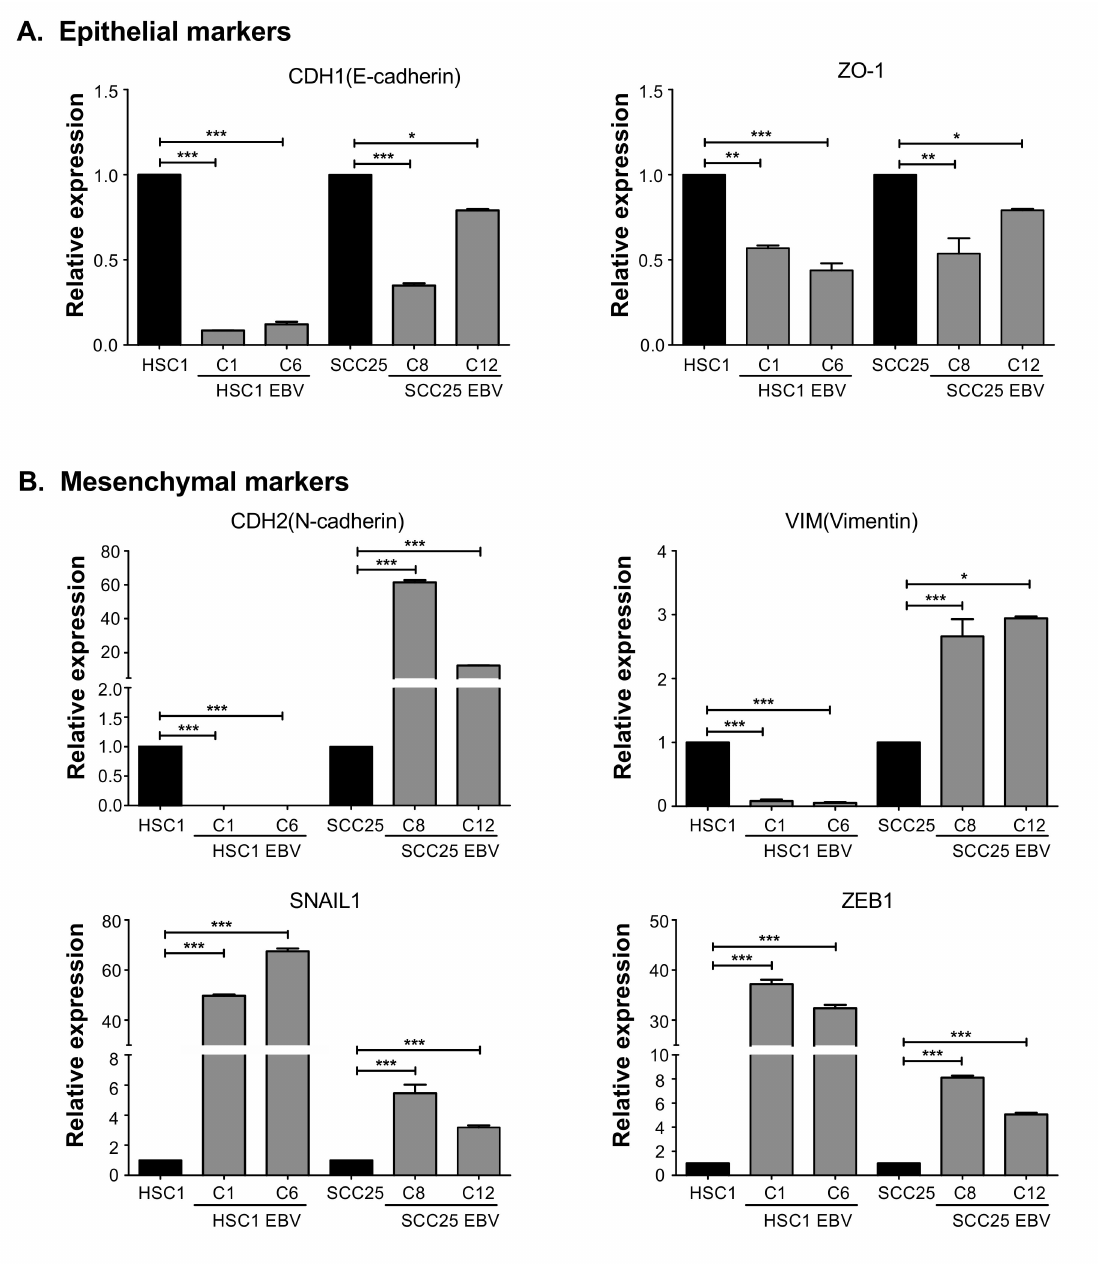
Figure 6. EBV infection induces mesenchymal properties in SCC cells. The expression of genes associated with EMT, including epithelial markers ( A ) CDH1, ZO-1, and mesenchymal markers ( B ) CDH2, VIM, ZEB1, and SNAIL1, was quantitated by qRT-PCR. *: p < 0.05; **: p < 0.01; ***: p < 0.001. 3.6. EBV Promotes Migration and Invasion in SCC Cells. Cell migration was examined by wound healing assay and transwell assay. EBV infection significantly promoted migration in both HSC1 EBV C1 cells and SCC25 EBV C12 cells as early as 12 h after incubation (Figure 7A,B). Similarly, EBV infection induced cell invasion in both HSC1 EBV cells and SCC25 EBV cells (Figure 7C). These results showed that EBV promotes tumor metastasis by inducing migration and invasion in SCC